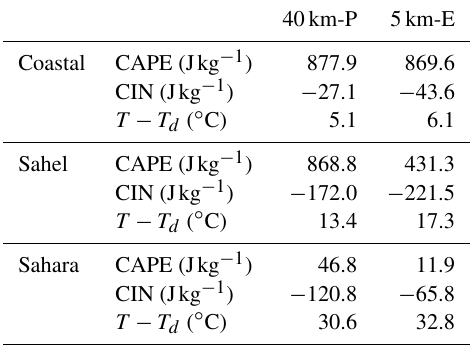
Table 1. JAS mean values of CAPE, CIN and dew-point depression for the coastal, Sahel and Sahara regions (Fig. 1).